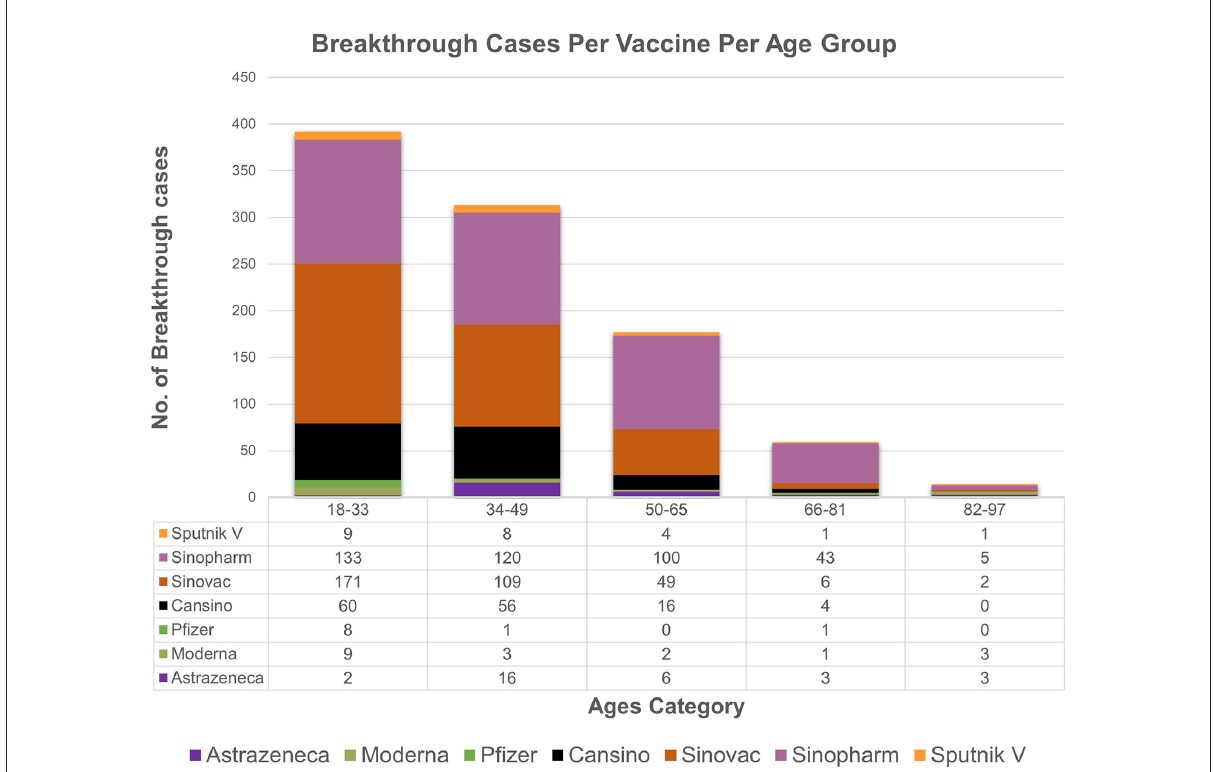
FIGURE3 The age wise distribution of vaccines breakthrough cases. The majority of breakthrough cases occur in subjects aged 18–33( n = 392), followed by subjects aged 34–49 ( n = 313).